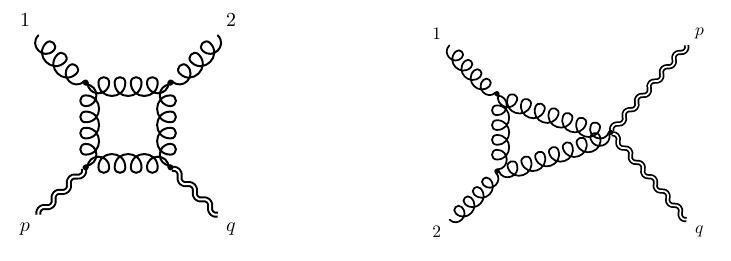
Figure 16 . The κ 2 g 2 order of the two-gluon-two-graviton amplitude in (5.17) is given by the depicted boxes and